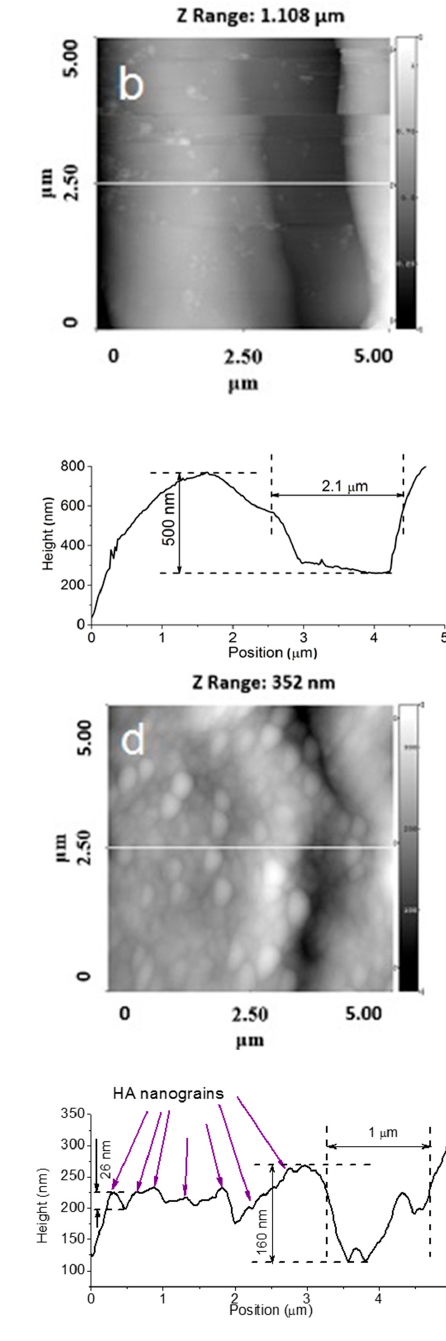
Figure 2. Atomic force microscopy (AFM) images of the surface topographies of Ti samples with parallel grooves and a periodicity of approximately 4.5 µ m. ( a ) 35 × 35 µ m 2 ; ( b ) 5 × 5 µ m 2 without a HA film; ( c ) 35 × 35 µ m 2 ; and ( d ) 5 × 5 µ m 2 with a HA